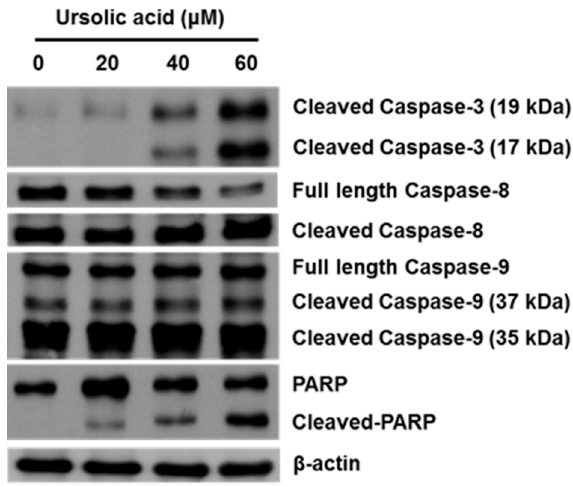
Figure 7. Activation of caspase-3, caspase-8, caspase-9, and PARP protein expression in SK-Hep-1. SK-Hep-1 cells were treated with UA (0, 20, 40, and 60 μ M) for 24 h and the protein expression was evaluated by western blotting. The results showed that UA treatment resulted in increased protein expression of cleaved caspase-3, cleaved caspase-8, cleaved caspase-9, and cleaved PARP. β -Actin served as a loading control.